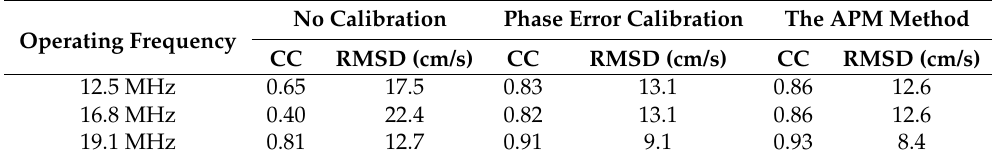
Table 4. Radial current measurements with the Zhujiajian MHF radar using three calibration strategies.